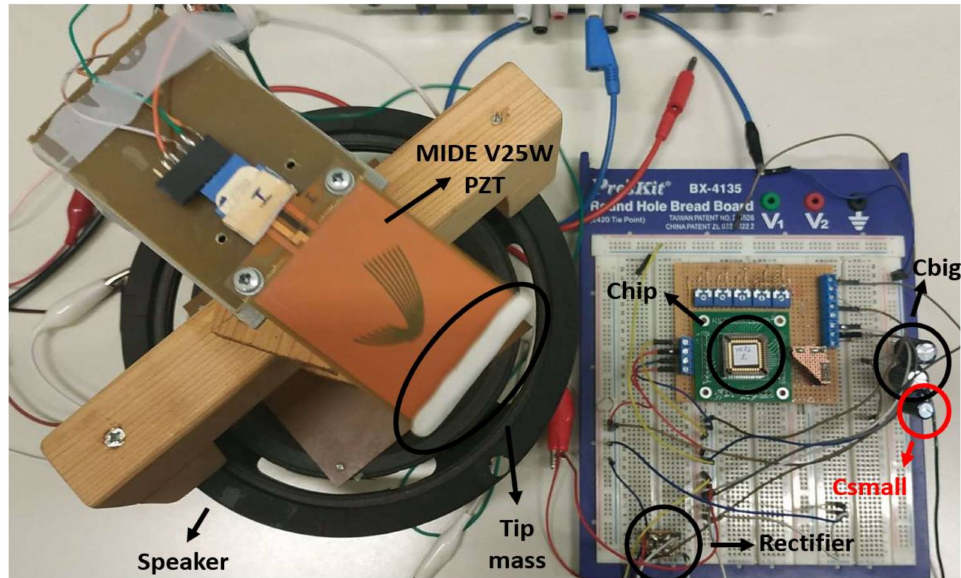
Figure 14. Experimental setup for testing the storage unit with mechanical vibrations harvesting.